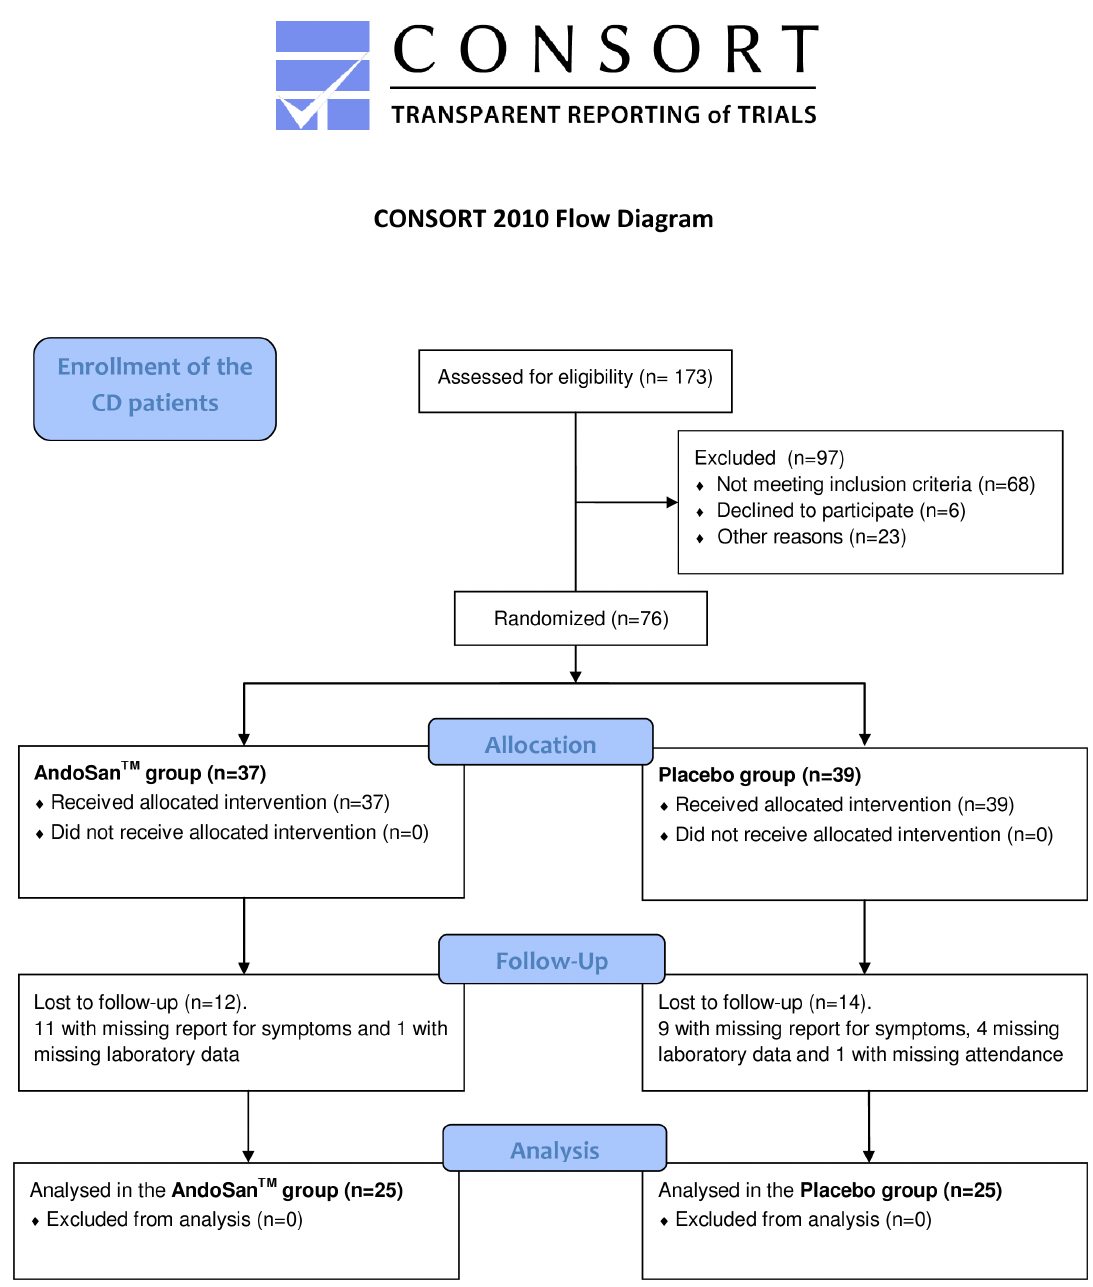
Fig 1. An algorithm showing the scheme for inclusion of the patients in the